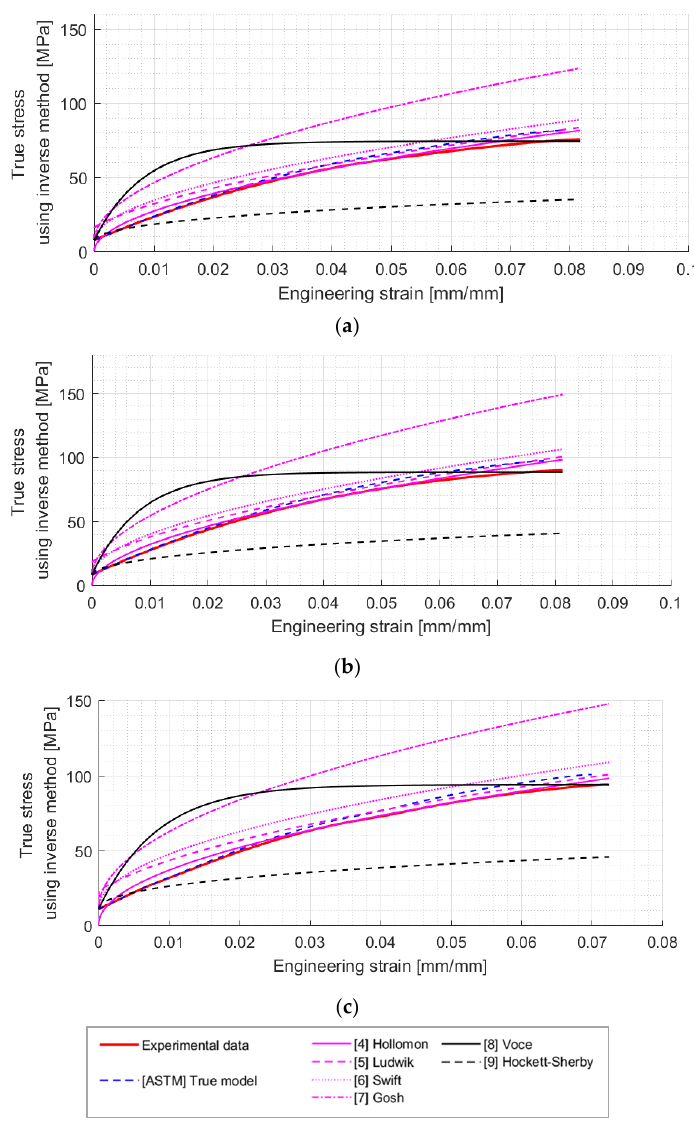
Figure 6. Theoretical true S–S curves: ( a ) GFRP wt 20% GF; ( b ) GFRP wt 30% GF; ( c ) GFRP wt 40% GF.